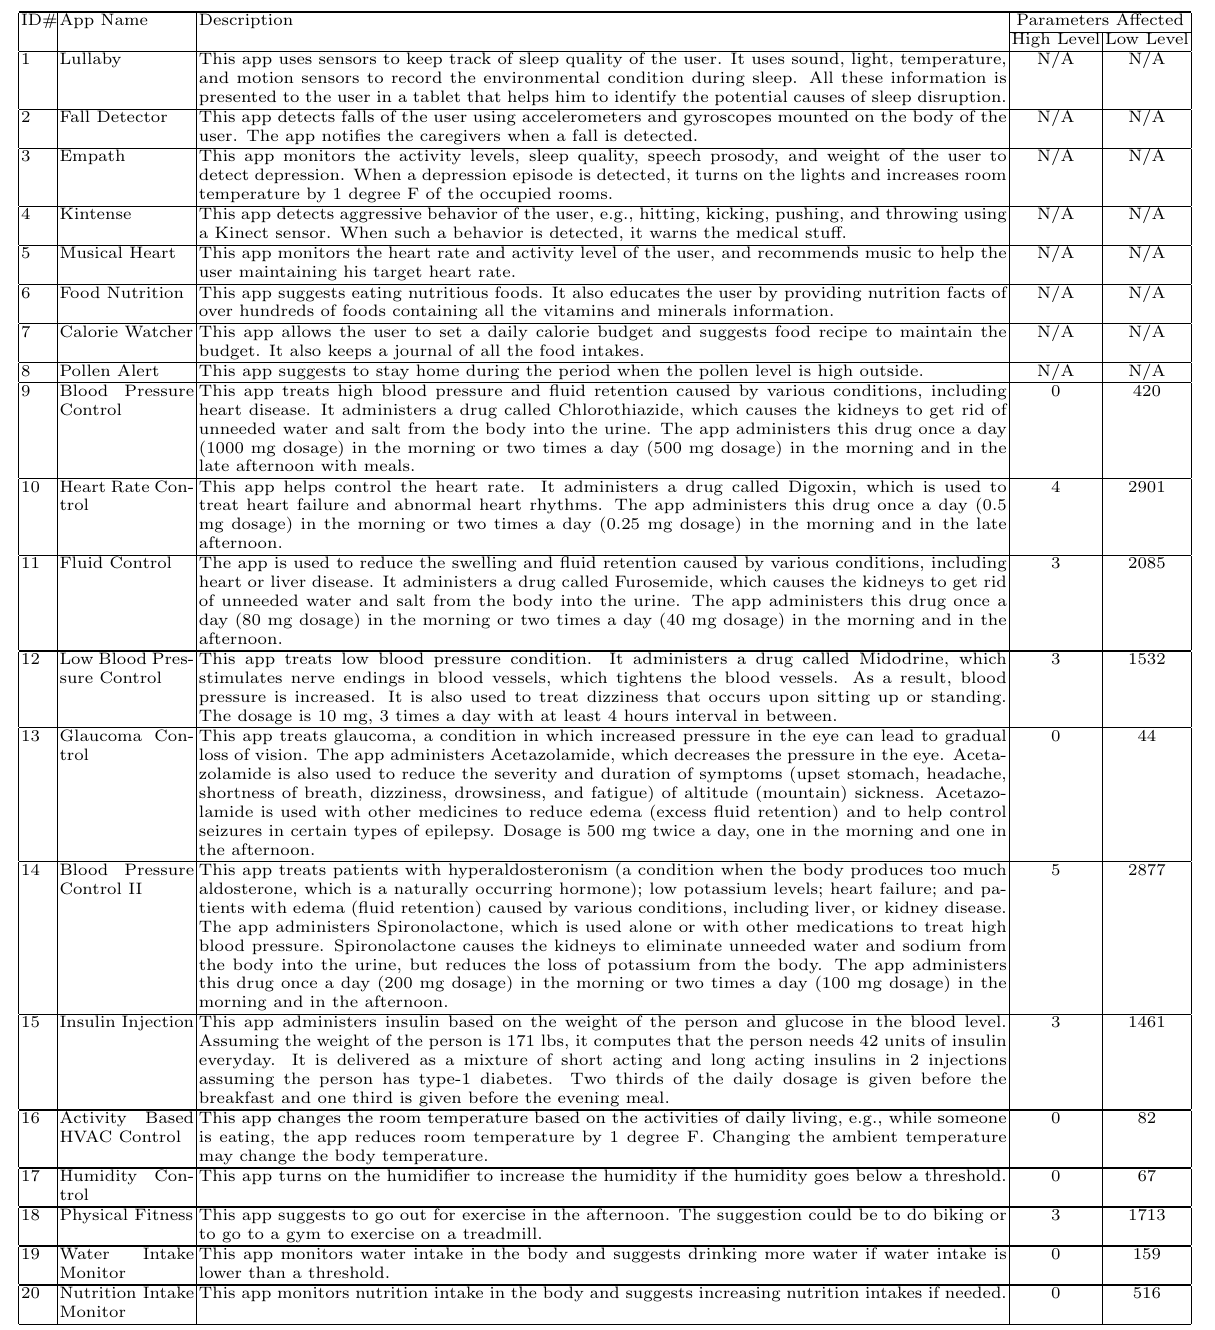
Table 1: A List of Human-in-the-Loop Apps rate is between 60 and 100 beats per minute, and tempera- ture is between 97.8 and 99.1 degrees